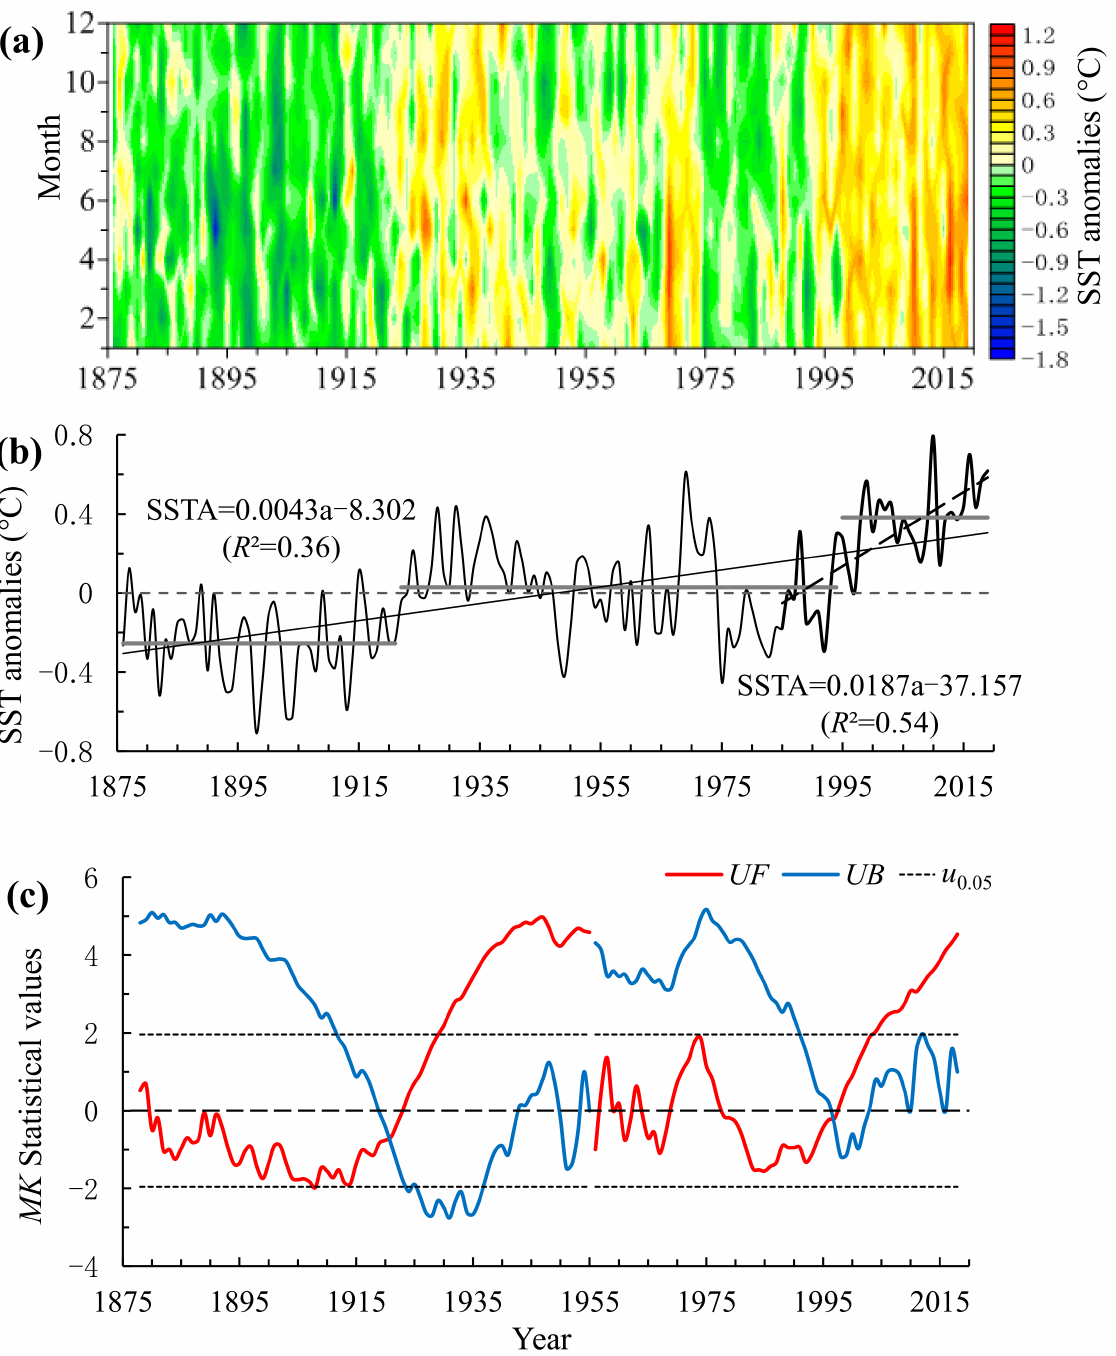
Figure 3. Long-term variations in SST, surface air temperature, and air–sea heat flux. ( a ) Monthly time series of anomalies of SST in Red Sea since 1876; ( b ) annual SST anomalies in Red Sea (two diagonal lines show the variation trends through linear fitting for 1876–2019 and 1985–2019; in two fitting formulas, “a” represents the year; three horizontal lines show the averages for 1876–1921, 1922–1994, and 1995–2019, respectively); ( c ) the variation trend of Red Sea SST, where UF and UB are MK statistics of time and time-reversed series, respectively, and u 0.05 = ± 1.96 are two critical lines. Two phases before/after 1955 were individually